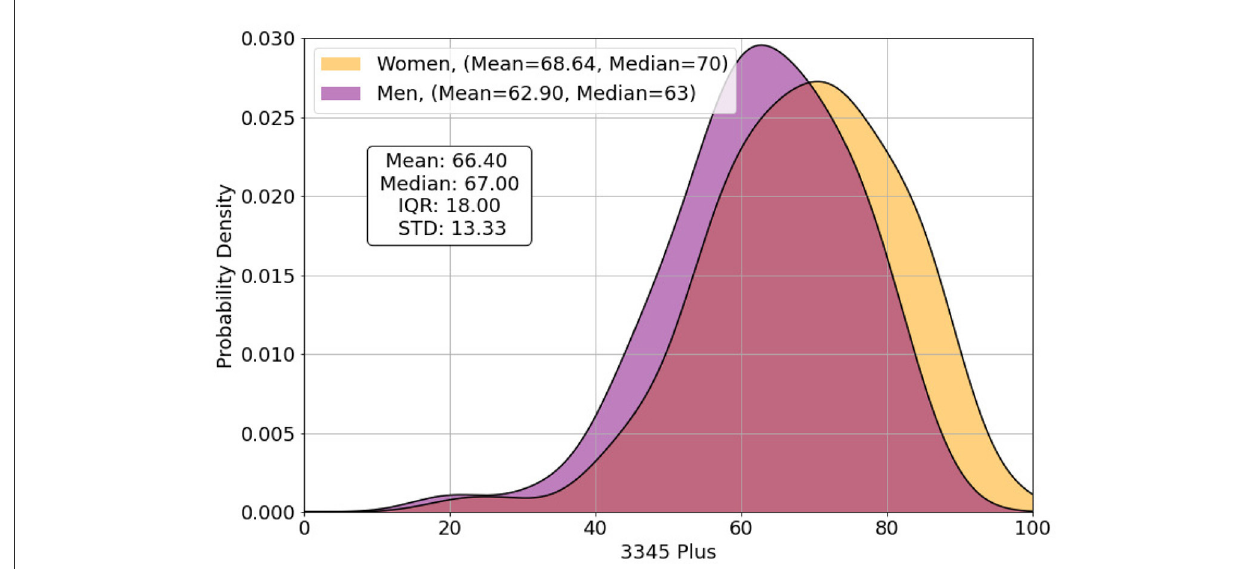
FIGURE2 The distribution of the respondents’ scores of the LEAS measured by the computer’s 3345plus score.